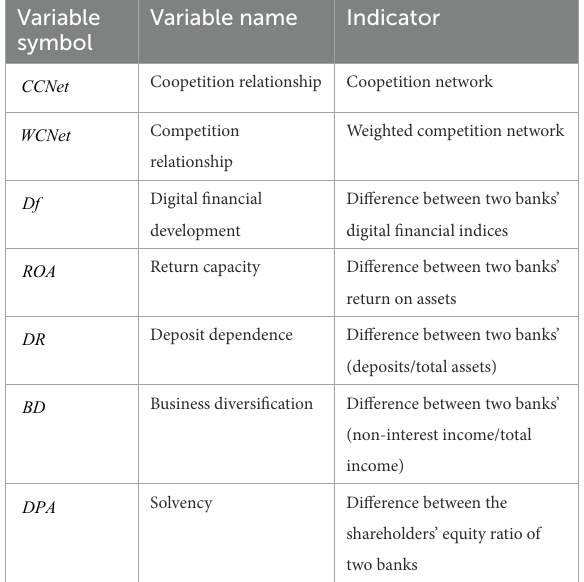
TABLE 1 Variable